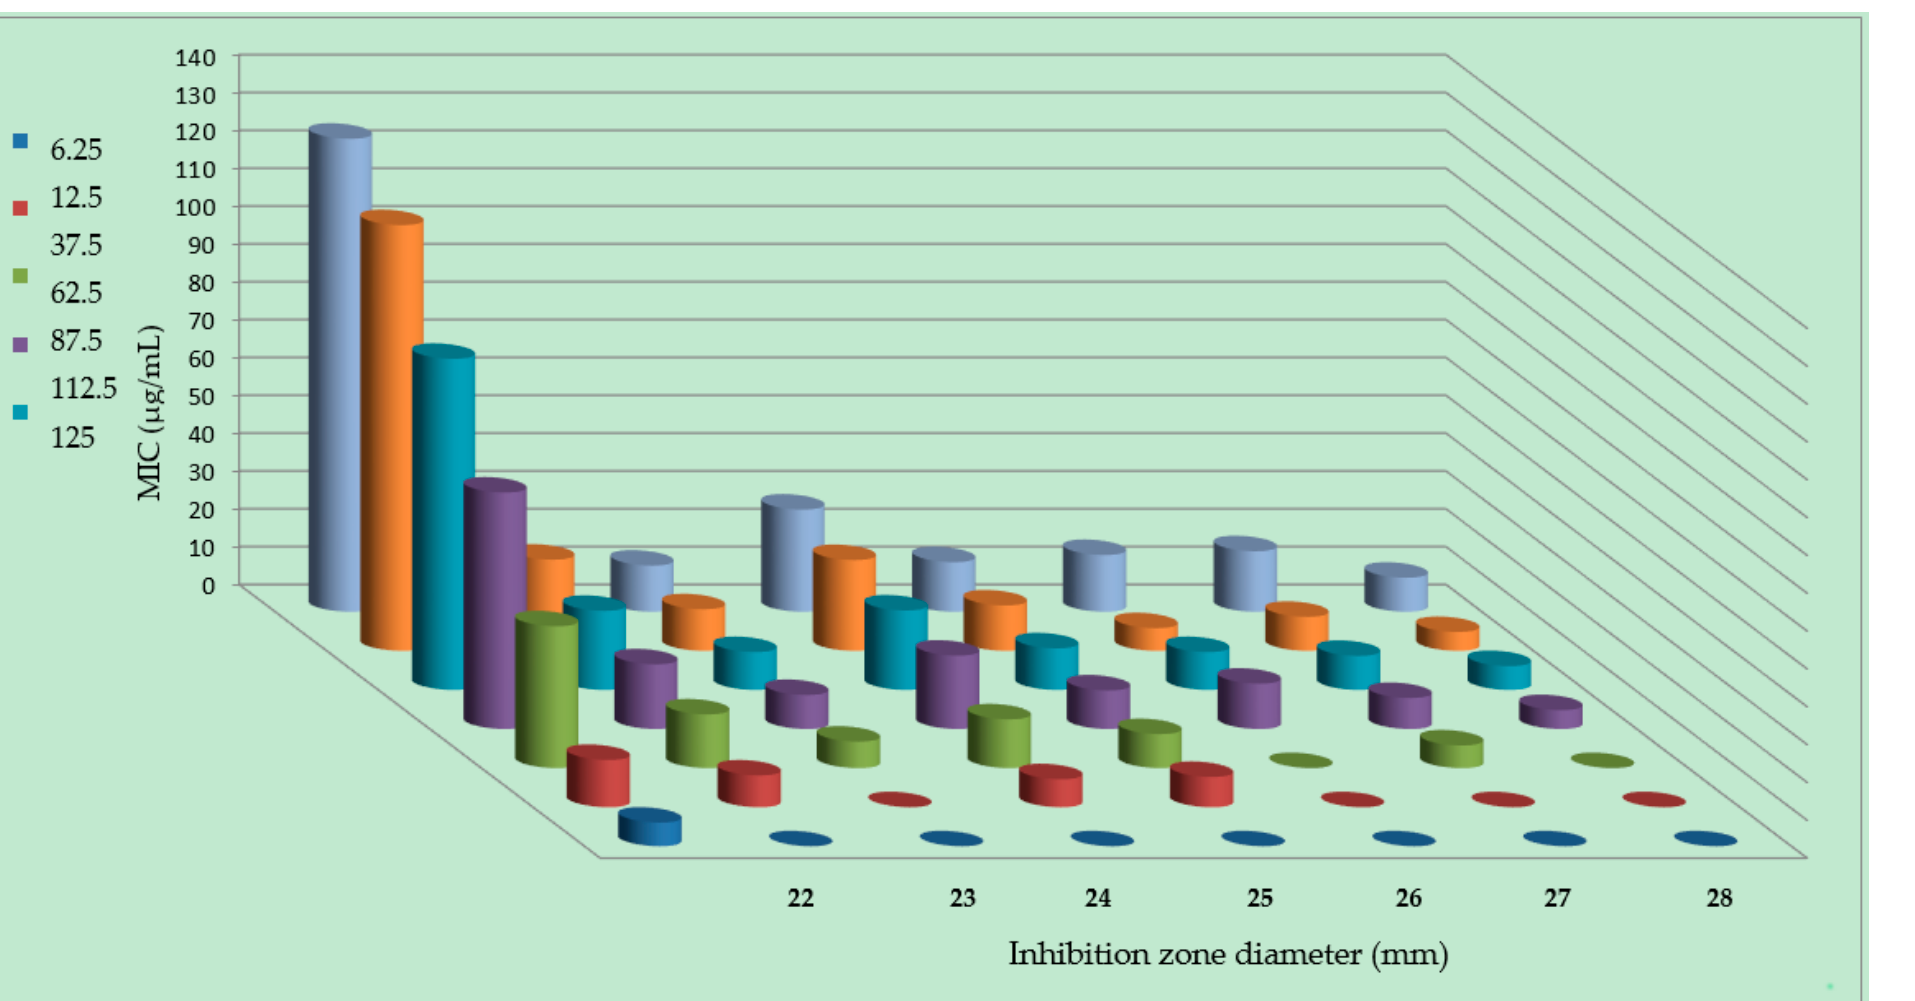
Figure 3. Antibacterial susceptibility of species E . coli given as MICs values in µg/mL for compounds 22 – 28.